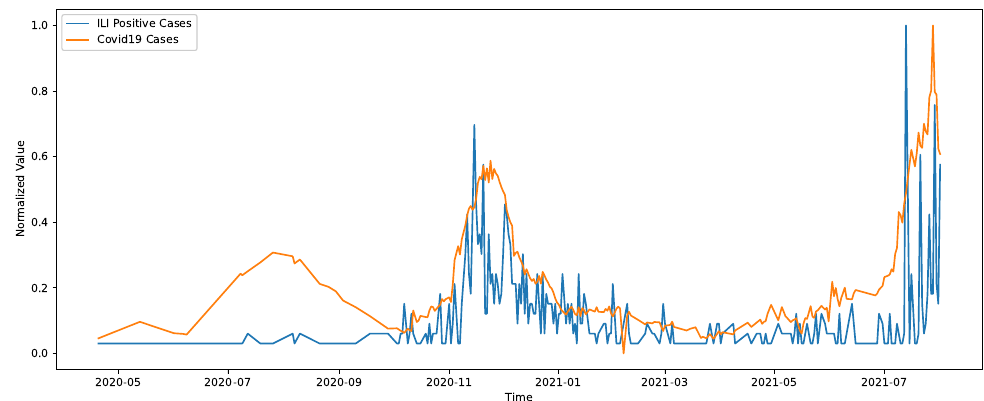
Figure 3. The positive ILI cases observed in our data compared to the COVID-19 cases from 20/04/2020 to 01/08/2021.